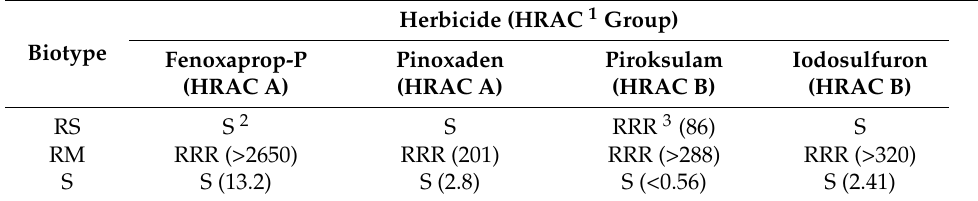
Table 2. Characteristics of herbicide-susceptible (S) and -resistant (RS and RM) biotypes of silky bentgrass ( Apera spica-venti (L.) P. Beauv) used in the pot experiments. Numbers in brackets relate to the effective dose of active ingredient causing a 50% of reduction in plant biomass (ED50).